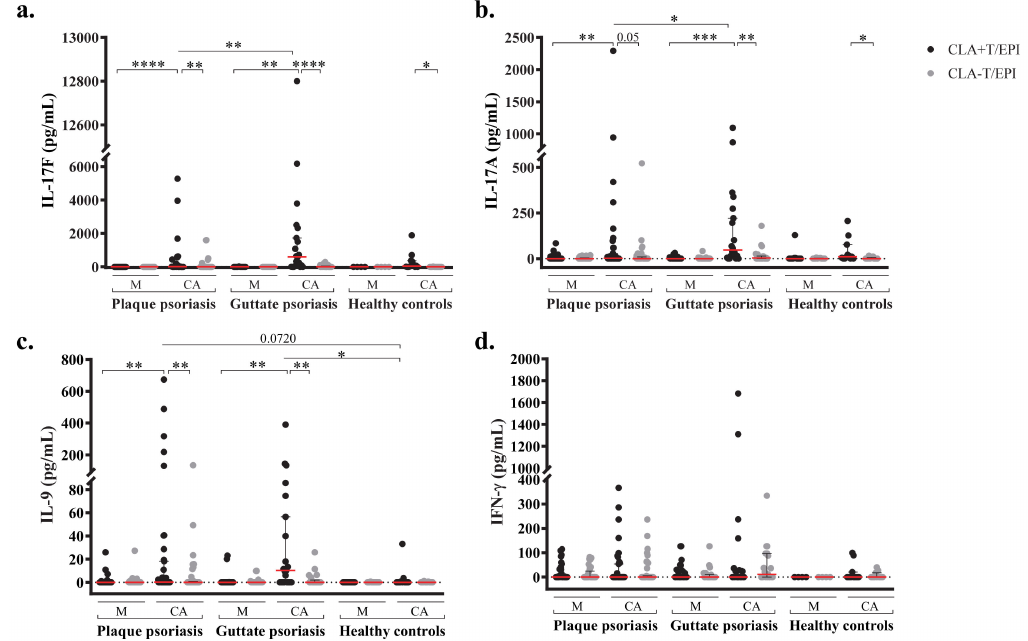
Figure 2. Th17 and Th9 responses to C. albicans are confined to CLA + T cells. IL-17F ( a ), IL-17A ( b ), IL-9 ( c ) and IFN- γ ( d ) levels were measured in culture supernatants from CLA + or CLA − T cells cocultured with autologous epidermal cells (EPI) after 5 days, in basal conditions (M) and stimulated with C. albicans (CA), in plaque psoriasis ( n = 31), guttate psoriasis ( n = 21) and healthy controls ( n = 12). Column bars are represented as mean with 95% confidence interval. Wilcoxon test was used to compare two conditions within psoriasis or controls (double-pointed line), whilst Mann–Whitney test was used to compare psoriasis versus controls (single-pointed line). For both, p values are indicated as ns: p > 0.05; *: p < 0.05; **: p < 0.01; ***: p < 0.001; ****: p <